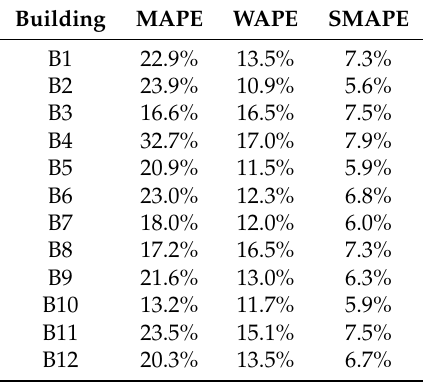
Table 6. Prediction error for each building: random forest regression model, time frame: 6 a.m–10 p.m. Building MAPE